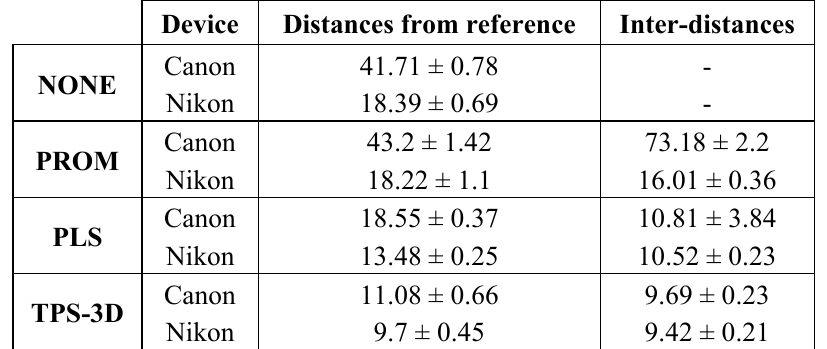
Table 2. Results of the Calibration Experiments (Sensors): values refer to the performance of the calibration methods taking into account the kind of device used for the taking the pictures (see Table 1 for